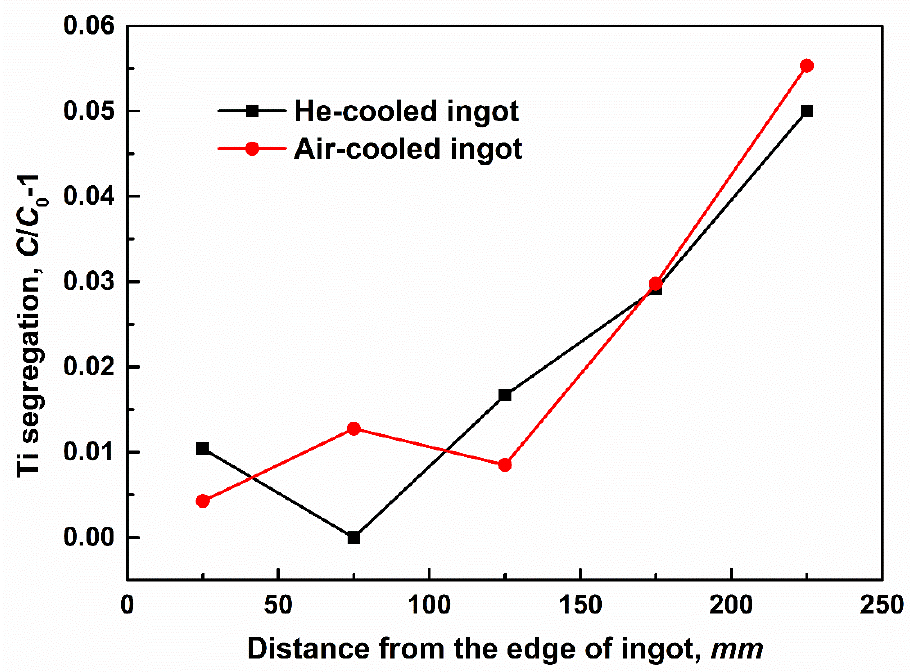
Figure 5. The comparison of Ti segregation from the edge to the center of He-and Air-cooled NbTi